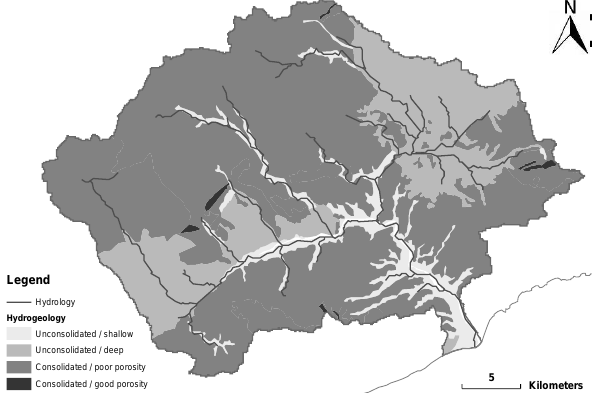
Fig. A1. Hydrogeological map of La Tordera catchment. Source: SGC, 1992.